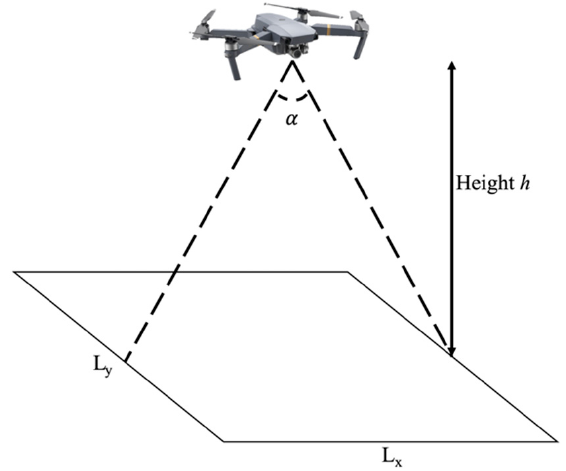
Figure 4. Graphical User Interface of the designed application with updated mine terrain.